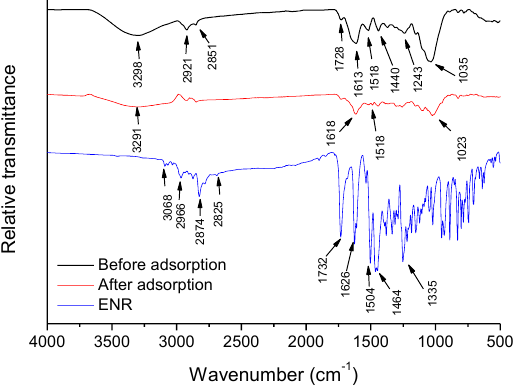
Figure 1. Fourier transform infrared spectra of the P. koidzumii sorbent (before and after adsorption) and the fluoroquinolone enrofloxacin.